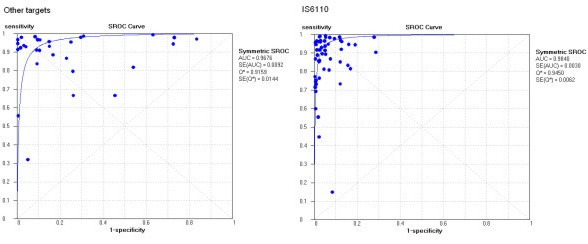
Effect of Significant Test Characteristics on Summary ROC curves: ROC curves for comparison among targets used in the in-house PCR assay (A) and different amplification techniques employed in the assays (B).